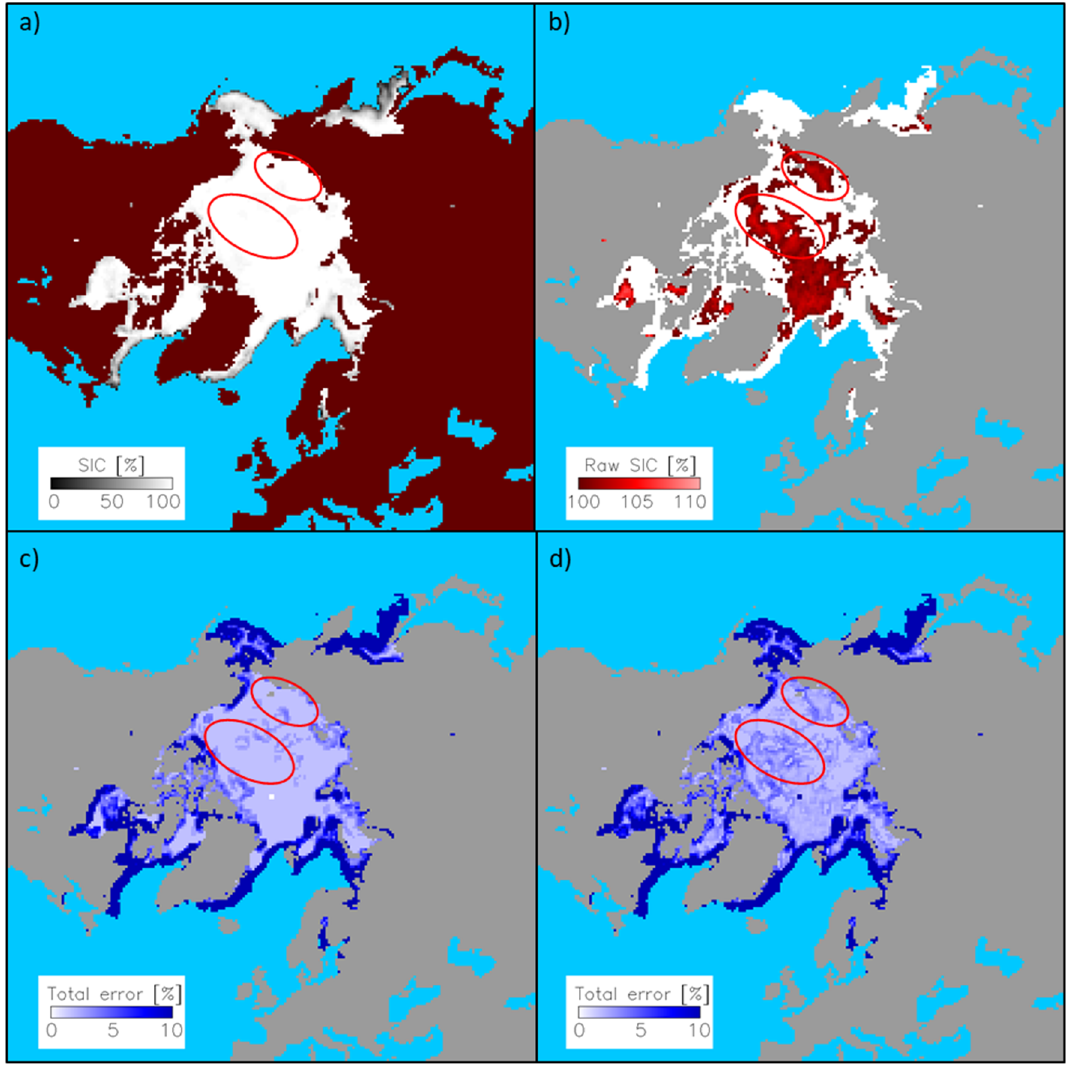
Figure 1. Maps of truncated SIC ( a ), non-truncated (=Raw) SIC focusing on values >100% ( b ), the original total error ( c ) and the corrected (see text) total error ( d ) of 3 April 2010, in the Northern Hemisphere. Shown are SICCI-50km data. I optimized the range of total error values shown to better illustrate error variations in high-concentration areas; maximum values actually peak at ~40%. Red ellipses highlight two regions with a pronounced fraction of SIC > 100%, indicating in maps ( c , d ) how the total error changes in response to the correction carried out.